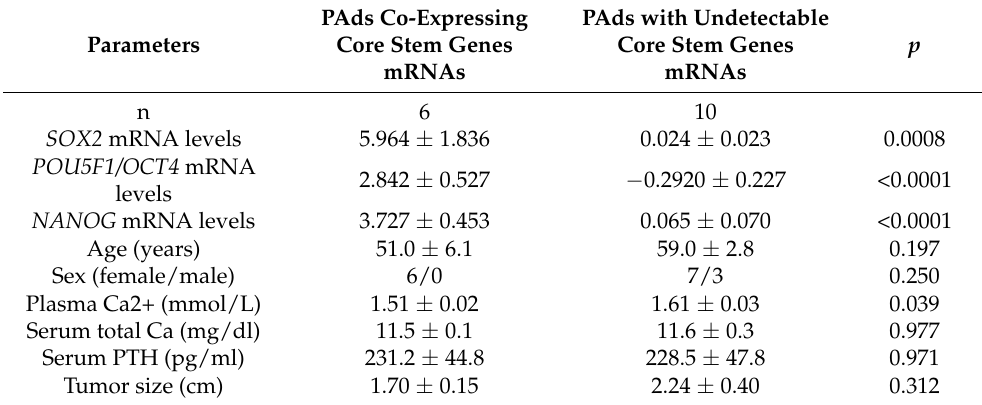
Table 1. Comparison of clinical and biochemical parameters between parathyroid adenomas co- expressing core stem genes and parathyroid adenomas with undetectable core stem genes. SOX2 , POU5F1/OCT4 , and NANOG transcripts were detected by qRT-PCR in total RNA from tumor samples; data are log2 transformed and presented as mean ± SEM. Comparisons were analyzed by Student’s t -test. PAds, parathyroid adenomas; n , number; Ca 2 + , plasma ionized calcium; Ca, serum total calcium; PTH, plasma